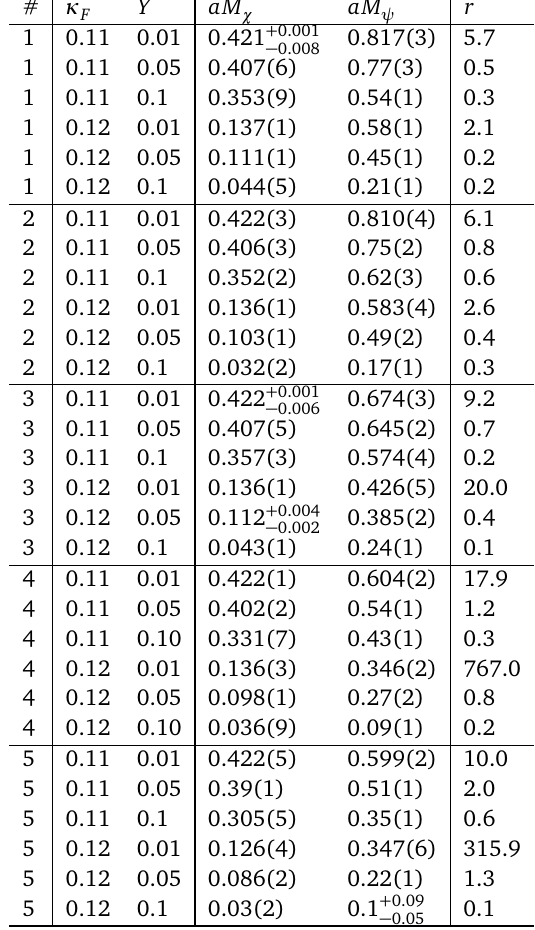
Table 3: The infinite-volume extrapolated results for the ground-state mass in the gauge-invariant and gauge-dependent channel, which are identified with the masses of the ψ and χ fermions, see text. The value of r from (30) is given for the 20 4 lattice, see also appendix A.